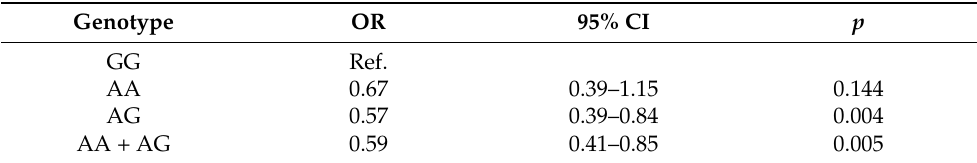
Table 3. NSCL/P risk and rs4147811 polymorphism in ABCA4 .